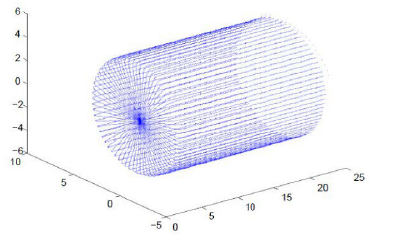
Figure 9. 3D reconstruction of 10 mm cylinder